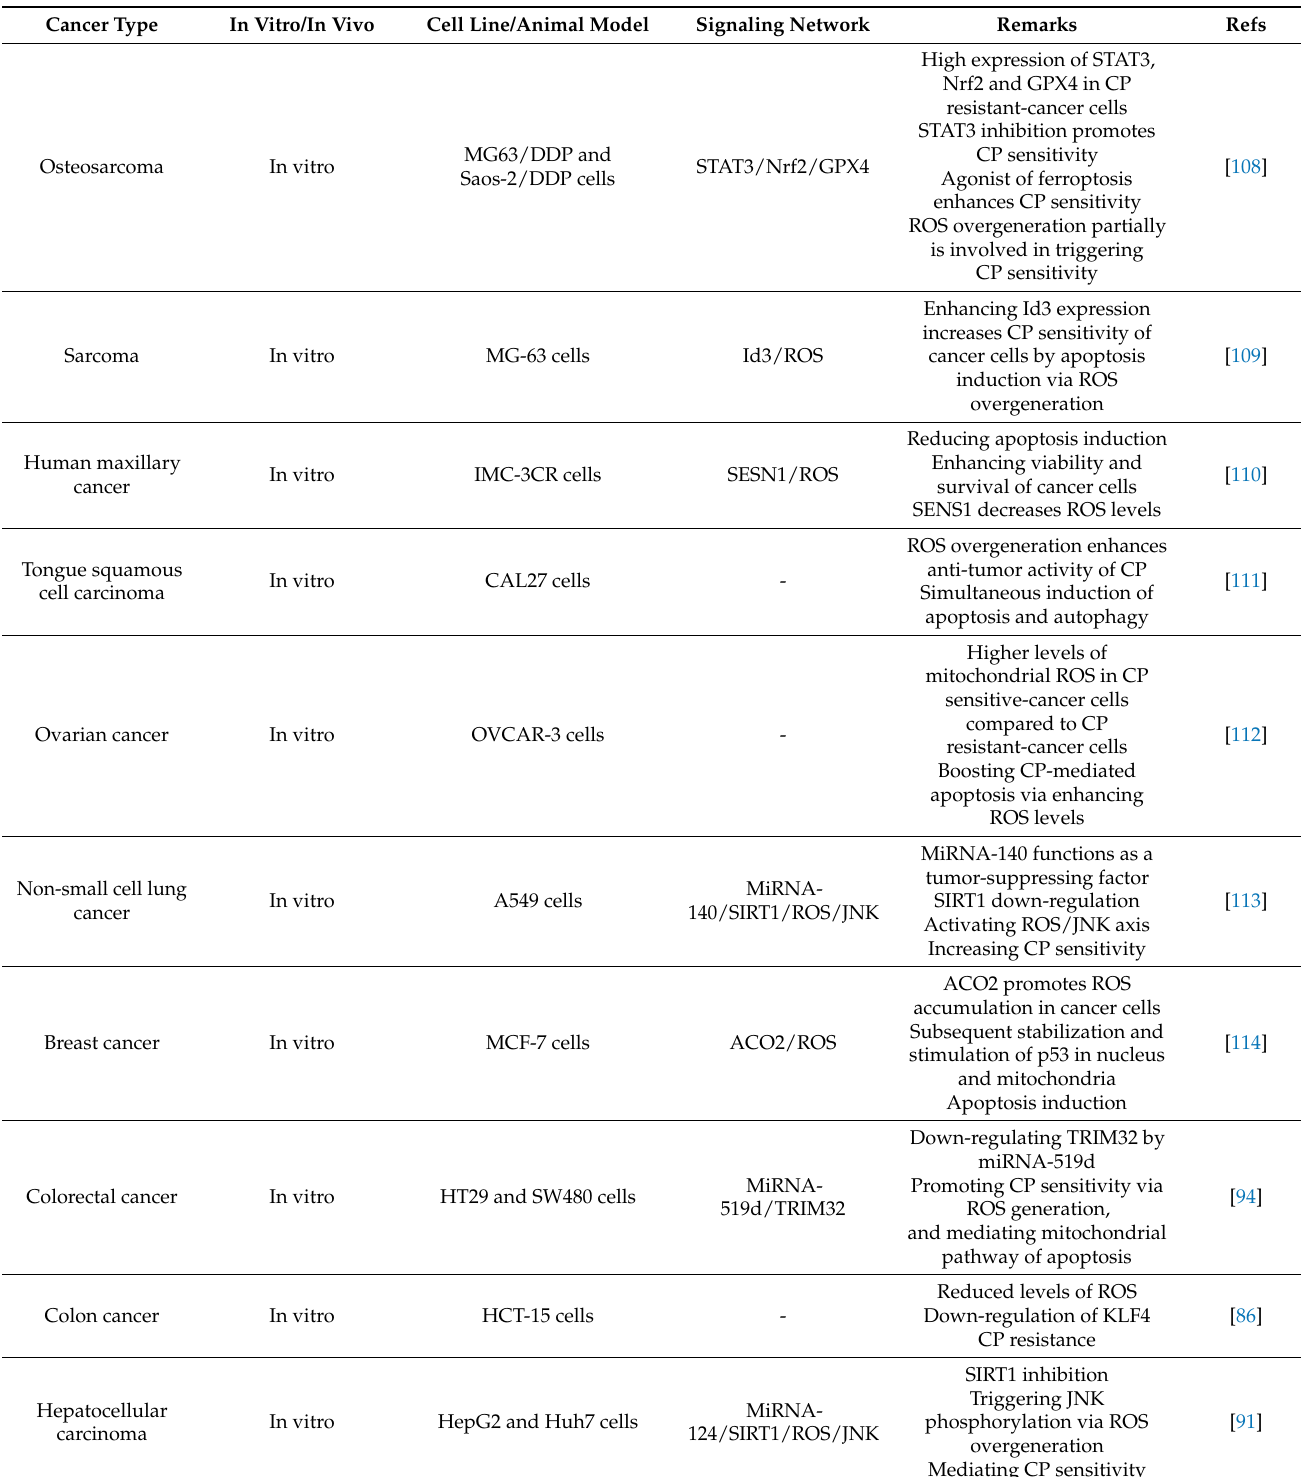
Table 1. Enhanced CP sensitivity of cancer cells via ROS